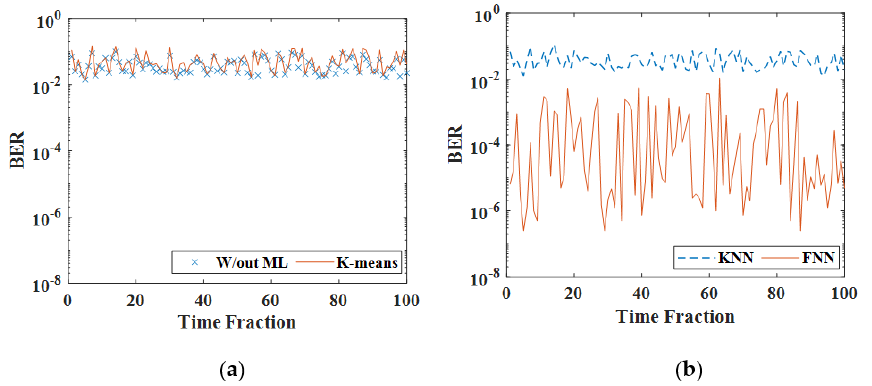
Figure 8. BER as a function of time fractions for: ( a ) without the use of ML (crosses), k − means clustering (line); ( b ) KNN (dashed line), FNN (line).